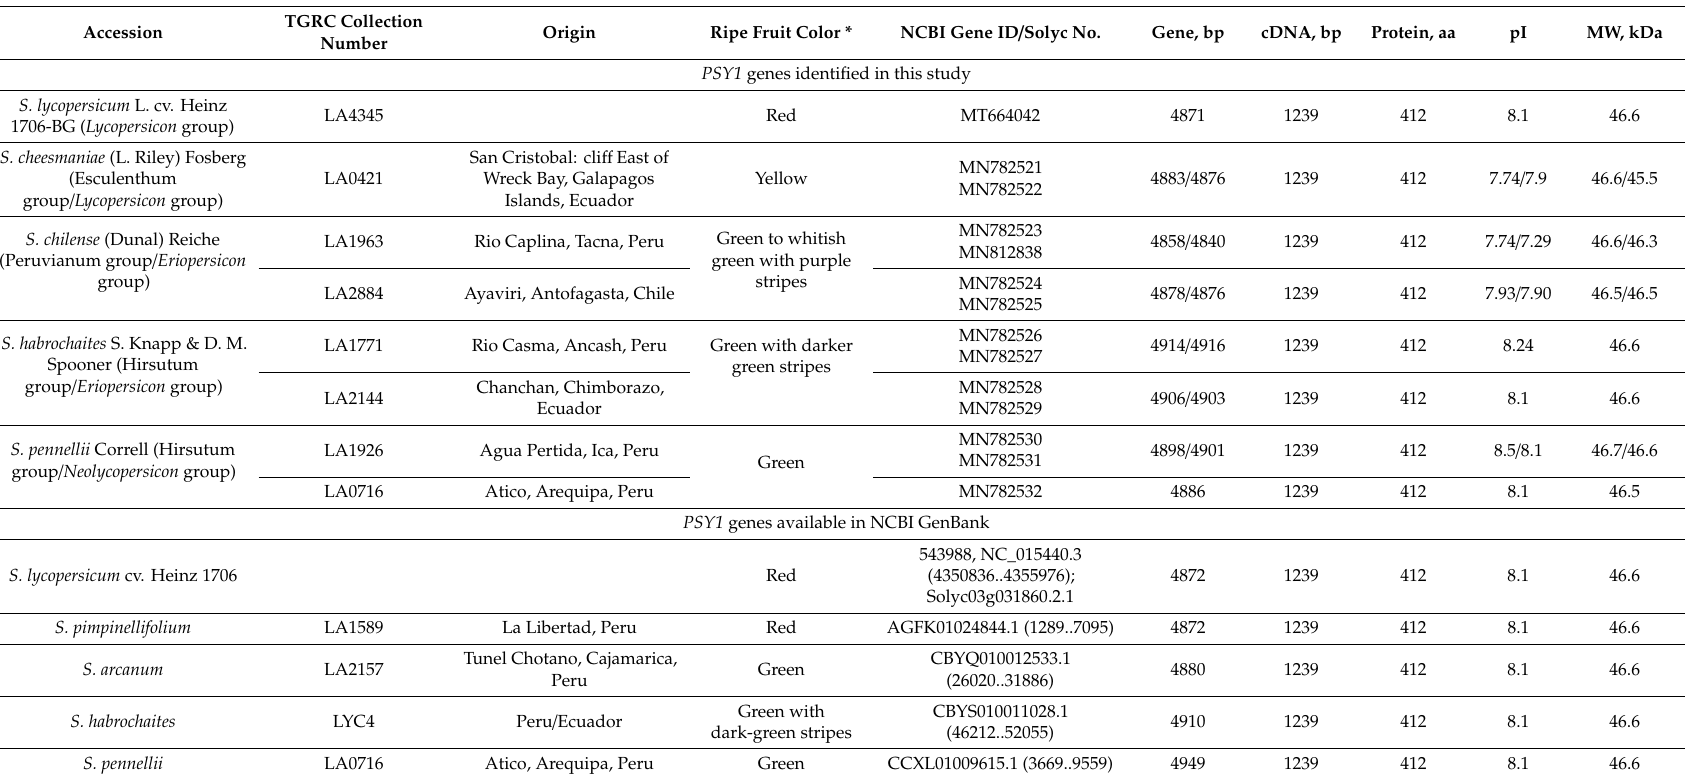
Table 1. Characteristics of PSY1 homologs from the analyzed Solanum section Lycopersicon